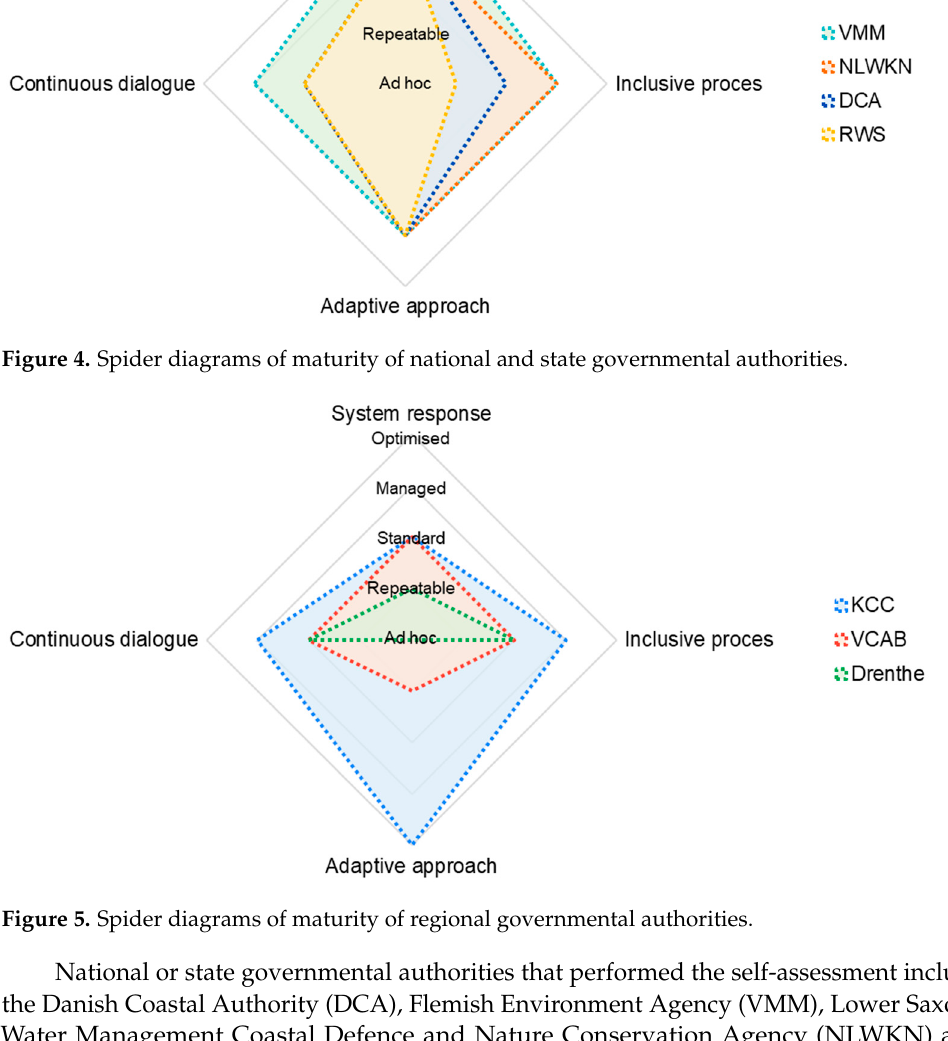
Figure 5. Spider diagrams of maturity of regional governmental authorities.